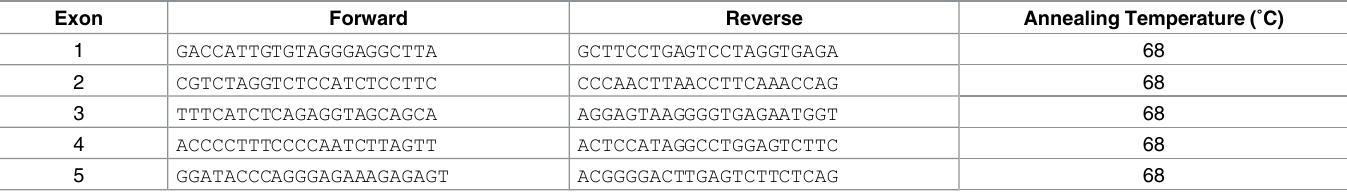
Table 1. Primer sequences used for the amplification of LIM2 coding